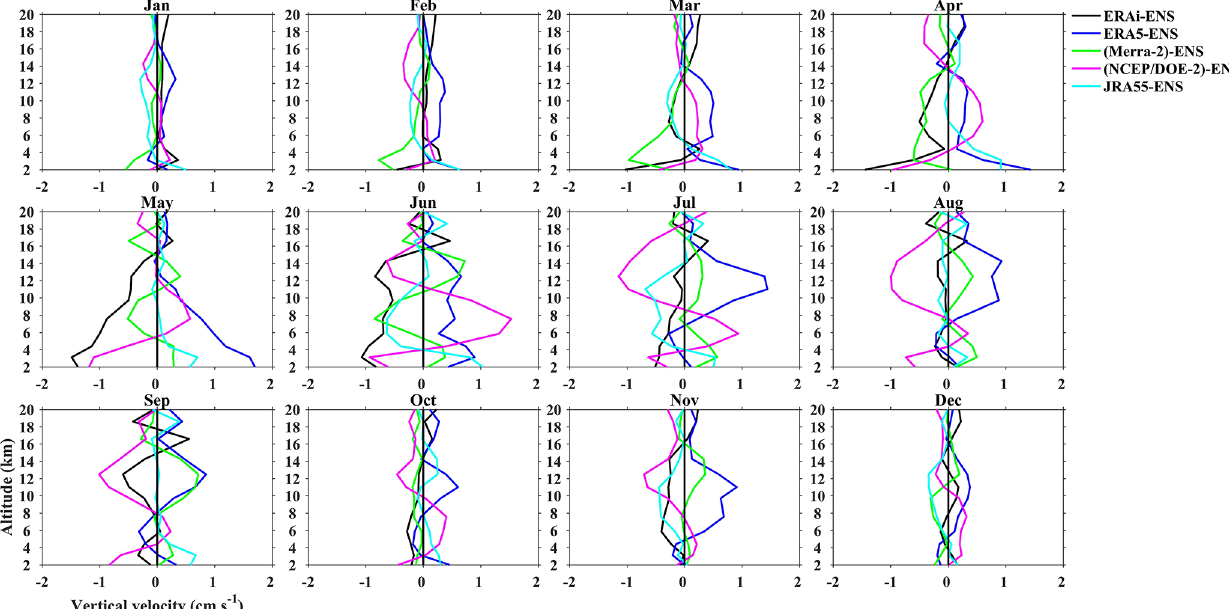
Figure 10. Comparison of relative differences in w between the reanalysis ensemble mean and each reanalysis for Gadanki from 1995 to 2015. Individual monthly differences are estimated and then averaged for each month.